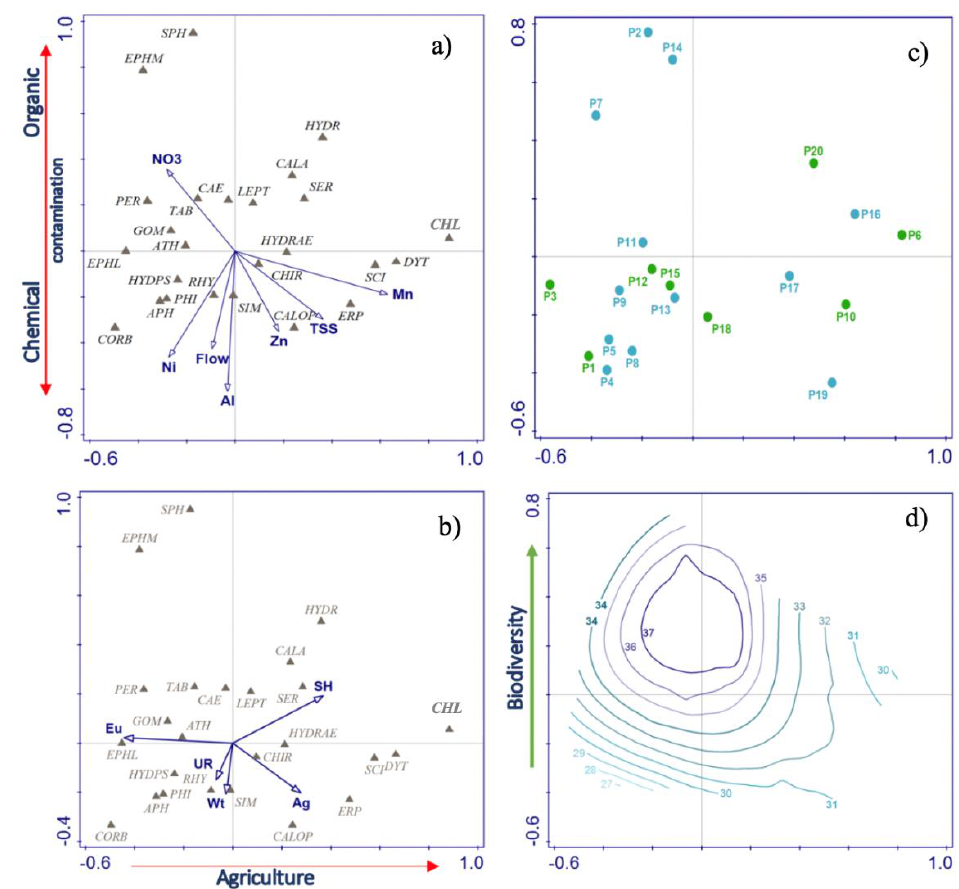
Figure 10. Correspondence Analysis (CA) bi-plot, in the ordination space of first and second axis, of the macroinvertebrate taxonomic assemblages and ( a ) physicochemical variables; and ( b ) Land-use land cover variables. ( c ) CA plot with the 20 sampling sites from the Paiva catchment; and, ( d ) contour plot of the taxa diversity within samples summarizing a fitted regression model (loess model). Only significant and independent environmental variables and more fitted taxa are shown. The red arrow shows the direction of the disturbance gradient and the green arrow the biodiversity gradient, common to all diagrams. Sites, taxa, and environmental codes are given in Table 1 and Table S2—Electronic Supplementary Material.